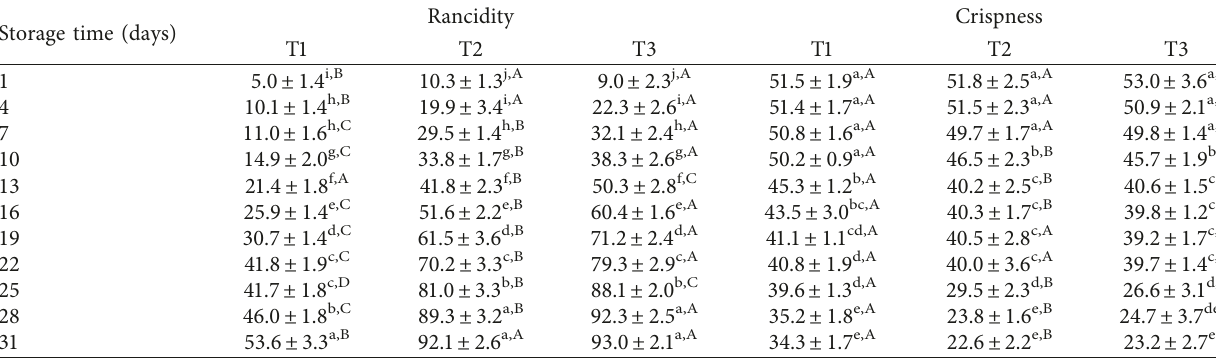
Figure 1: Hexanal contents of Kaeb Moo samples during storage. Table 3: Means of sensory attribute ratings of Kaeb Moo samples using 150mm